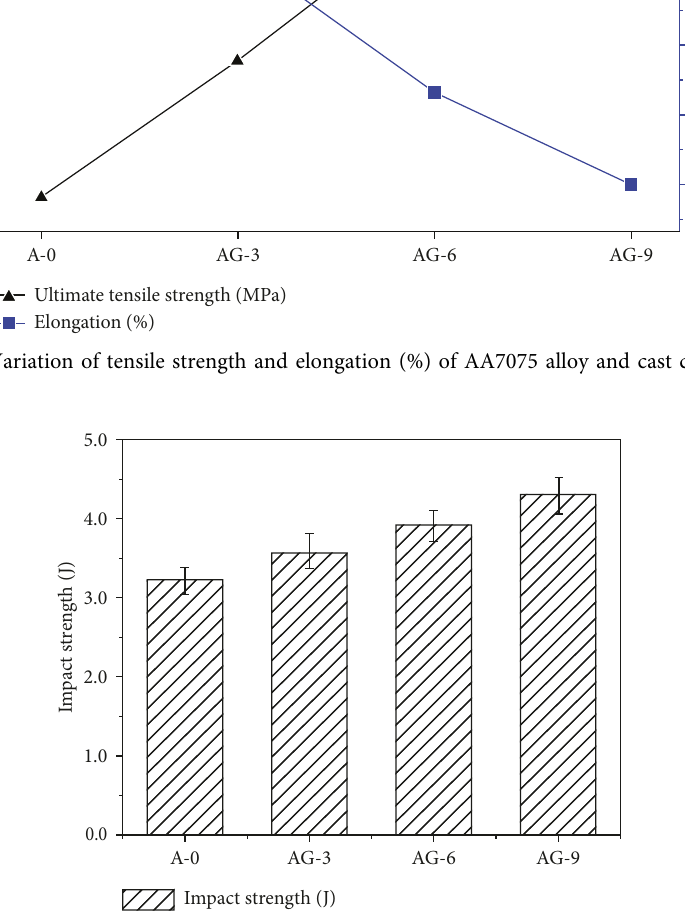
Figure 6: Variation of impact strength of AA7075 alloy and cast